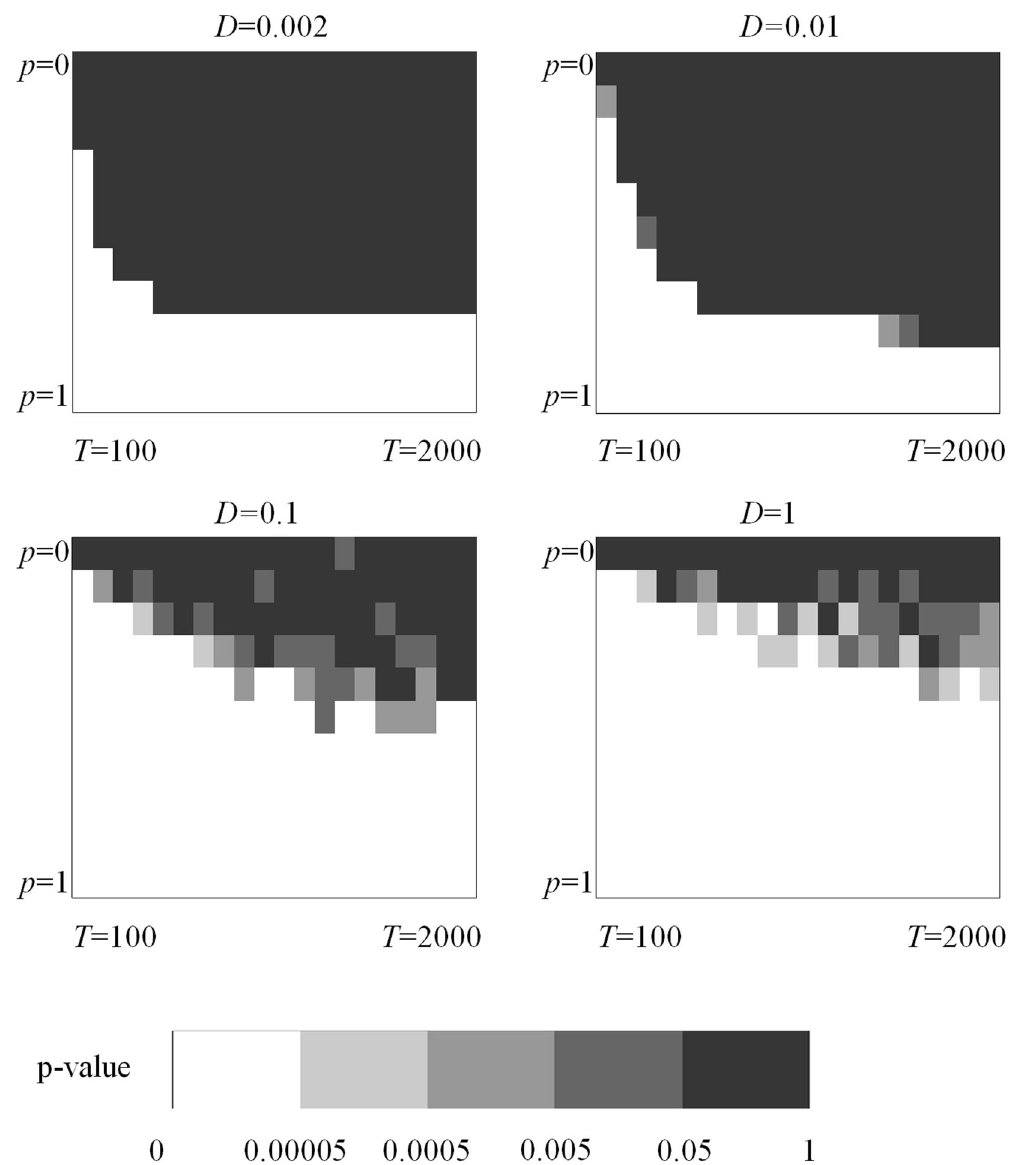
Fig. 5 The outcome of competition between the solitary-type strategy and the social-type strategy in the T - p parameter space for various values of D . The non-black squares indicate that solitary-type strategy outcompetes the social-type strategy more frequently than what is expected by random chance (i.e., when the simulation model is compared with the null model), with the brightness indicating the statistical signi fi cance of the result. A black square indicates that the frequency of the solitary-type strategy outcompeting the social-type strategy is not signi fi cantly different from what is expected by random chance at the 5% signi fi cance level. Values for other parameters are: M = 1000, N = 20, Q = 1, S = 1, E =